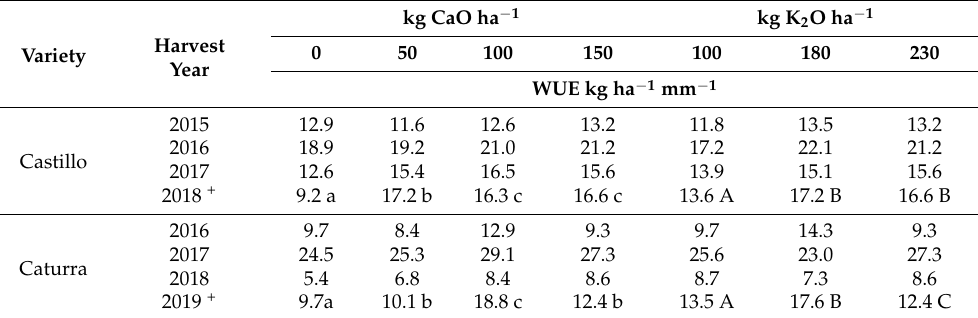
Table 5. Yearly water use efficiency for both coffee varieties under variable Ca +2 and K + rates.